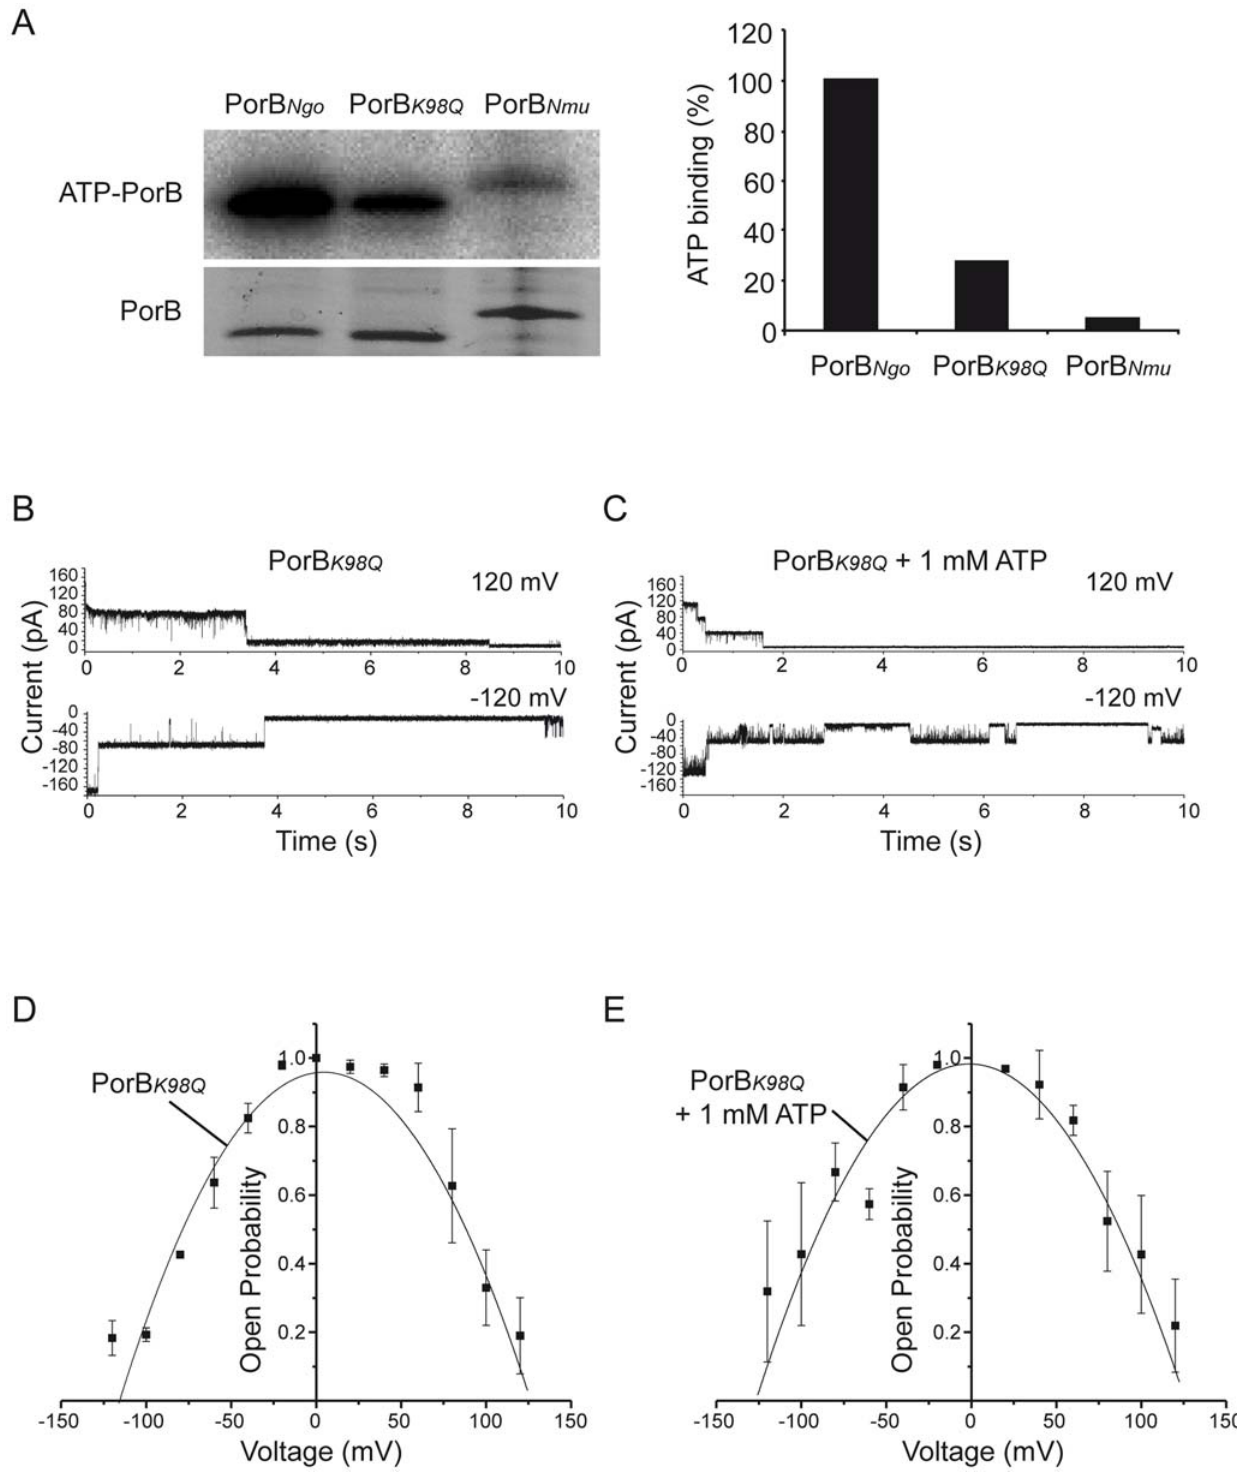
Figure 6. PorB K98Q channels are not modulated by ATP. ( A ) PorB K98Q is impaired in ATP binding. Neisserial strain N920 (PorB Ngo ), N886 (PorB K98Q ) and N923 (PorB Nmu ) were subjected to ATP binding assay as described in Materials and Methods. Bacterial lysates were separated by SDS- PAGE, and labelled PorB was visualized by exposing the dried gel to X-Ray films. The lower panel represents PorB as visualized by coomassie staining. For quantification purposes, the amount of ATP bound by the strain N920 was taken to be 100%. ( B,C ) Typical (n $ 5 independent bilayers) current recordings of a bilayer containing PorB K98Q at 120 mV and 2 120 mV. Buffer conditions were symmetric with 250 mM KCl, 10 mM Mops/Tris pH 7.0 in cis and trans . 1 mM ATP was added in cis and trans (C). ( D,E ) Voltage-dependent open probability of PorB K98Q in the absence (D) and presence (E) of ATP added to both sides of the membrane (n $ 3). Data are mean 6 SD.